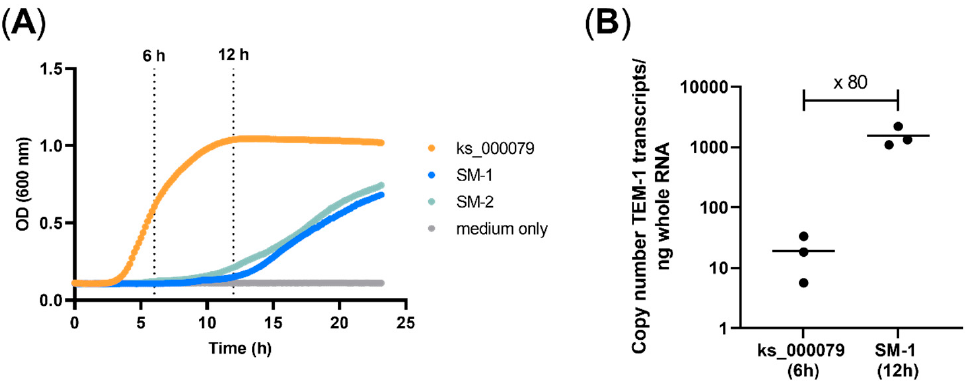
Figure 2. Characteristics of the expression E. coli model SM-1 compared to the clinical E. coli isolate ks_000079. ( A ) Comparison of the growth curves, ( B ) quantification of TEM-1 transcripts.